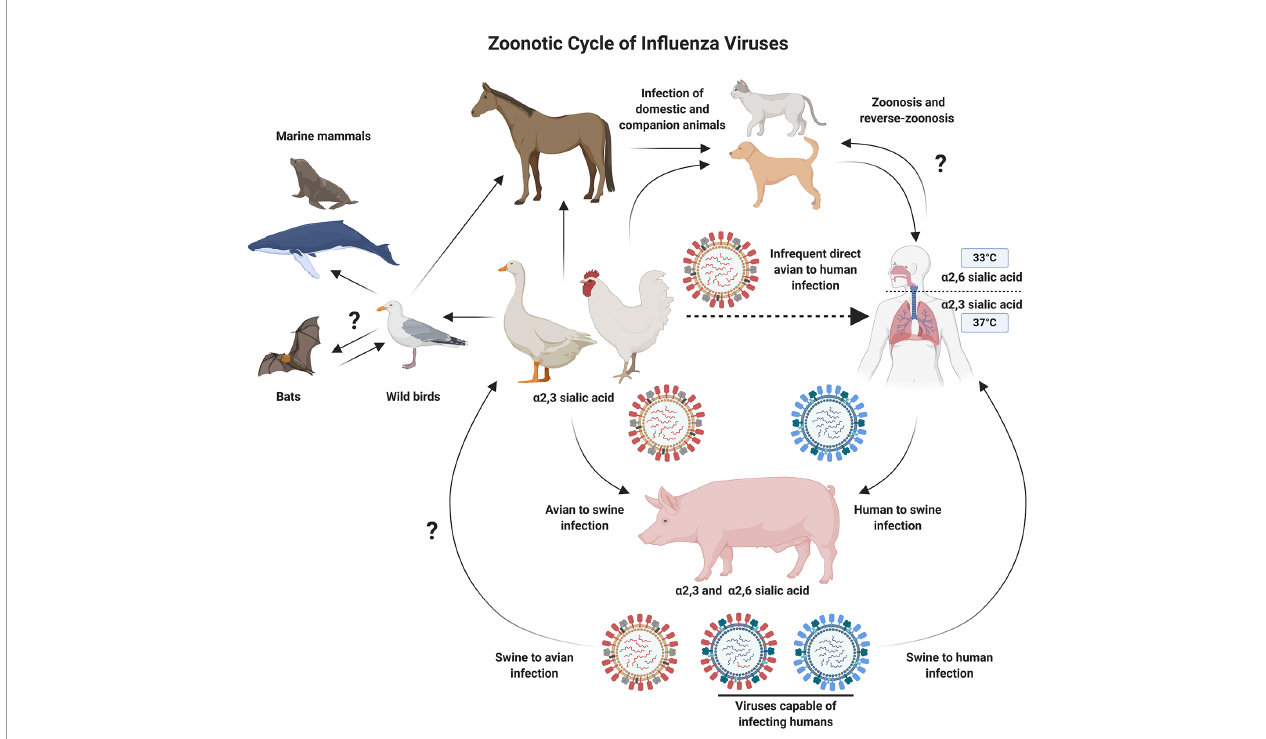
FIGURE 1 | Schematic Diagram Showing Zoonotic Cycle of In fl uenza Viruses. In fl uenza A viruses can infect multiple animal species, which increases the probability of cross-species transmission events. Migratory and aquatic birds represent natural reservoirs for avian in fl uenza viruses, and pigs act as a mixing vessel, allowing the reassortment of diverse in fl uenza viruses. The process of reassortment could lead to the emergence of novel in fl uenza subtypes which are better adapted for infection and transmission in humans. Several barriers to this process also exist, including, but not limited to receptor usage preferences. Direct infection of humans with avian in fl uenza viruses is an infrequent event. However, the potential for adaptation while maintaining high pathogenicity is a major concern and drives efforts to develop improved vaccines against emerging avian in fl uenza viruses. Figure created with © BioRender -